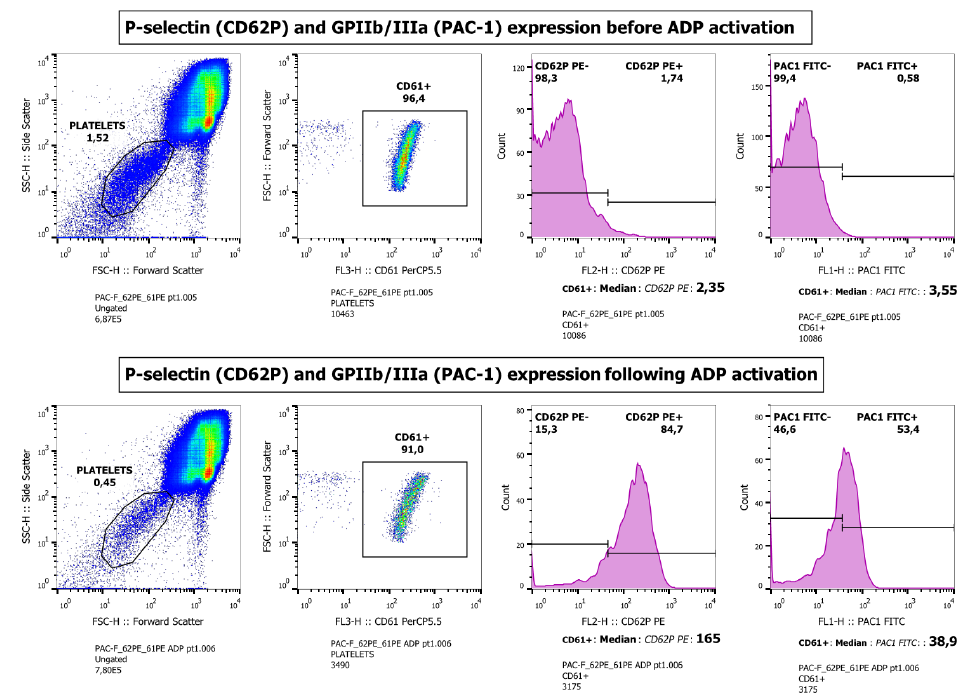
Figure 4. Platelet activation intensity assays. Platelets were studied both at rest and following ADP activation. Platelet population was initially identified via CD61 membrane receptor, and then histogram formation revealed membrane P-selectin and glycoprotein GPIIb/IIIa to assess their activation. Non-activated platelets at rest ( upper panel ) expressing membrane receptor CD61 were initially isolated. Consequently, subpopulations expressing surface CD62P and PAC-1 were identified, respectively. A similar process was carried out following ADP activation ( lower panel